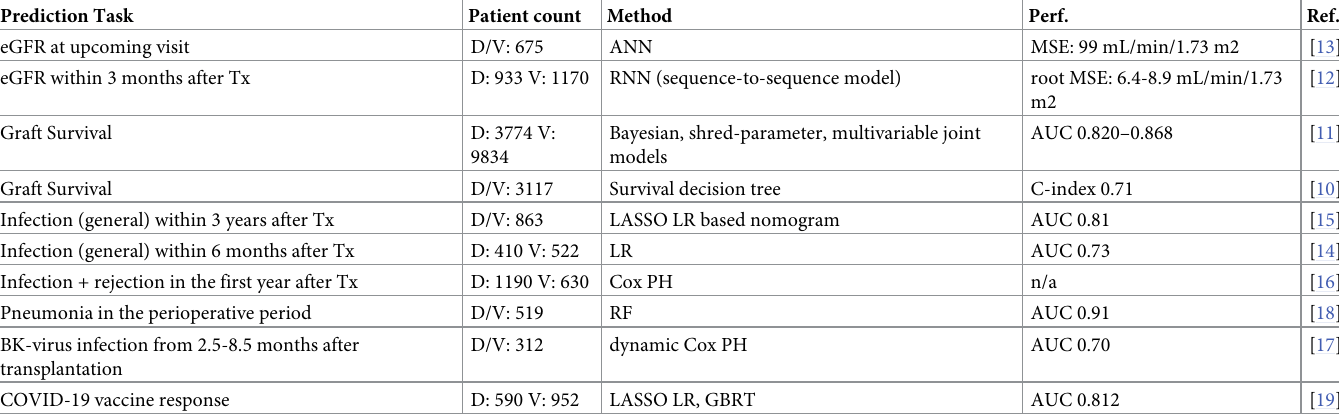
Table 1. Risk prediction models in the domain of kidney transplantation. Perf.—Performance during external validation or optimism corrected for internal validation, Ref—Reference, ANN—artificial neural network, RNN—recurrent neural network, LASSO—least absolute shrinkage and selection operator, LR—logistic regression, Cox PH—Cox proportional hazards regression, RF—random forest, GBRT—gradient boosted regression trees, Tx—transplantation, D development dataset, V: external valida- tion dataset, D/V: development and internal validation. Prediction Task Patient count Method Perf.